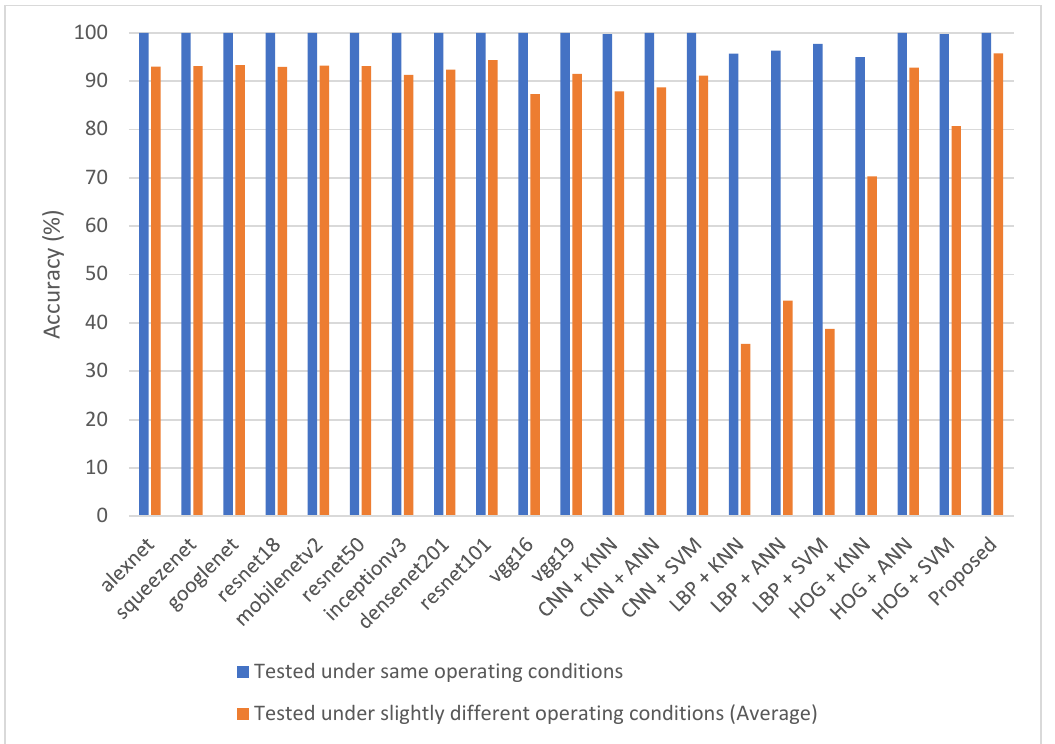
Figure 15. Impact of testing under slightly different operating conditions.